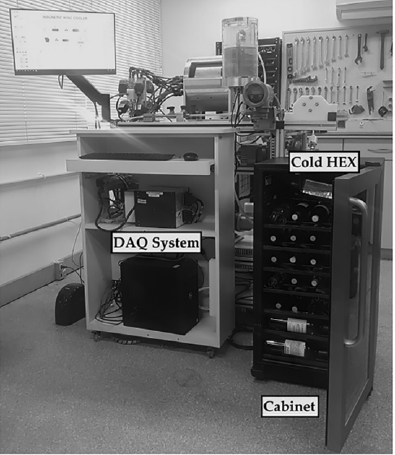
Figure 11. Pictures of the device test bench [51].